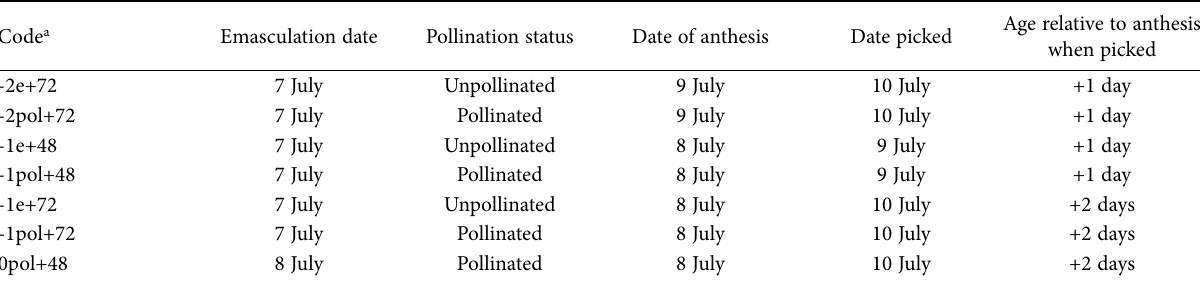
Table 1. Batches of Z. chlorosolen flowers used in this study. Code